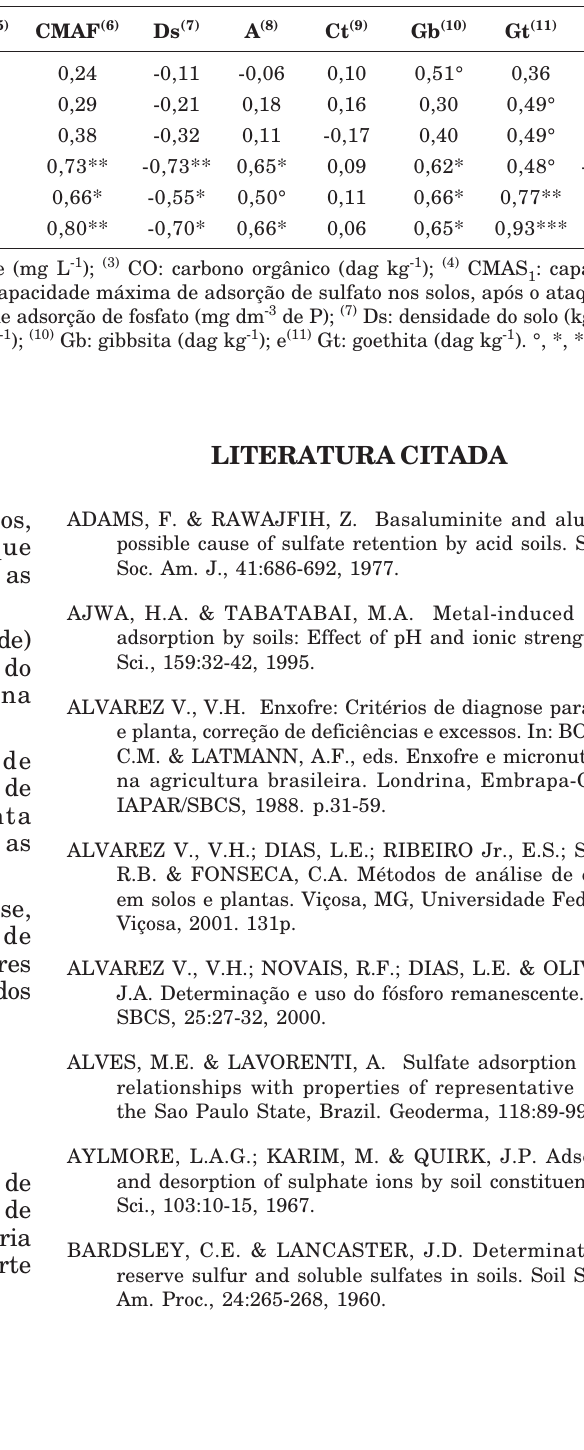
: capacidade máxima de adsorção de sulfato nos solos, após o ataque com 2